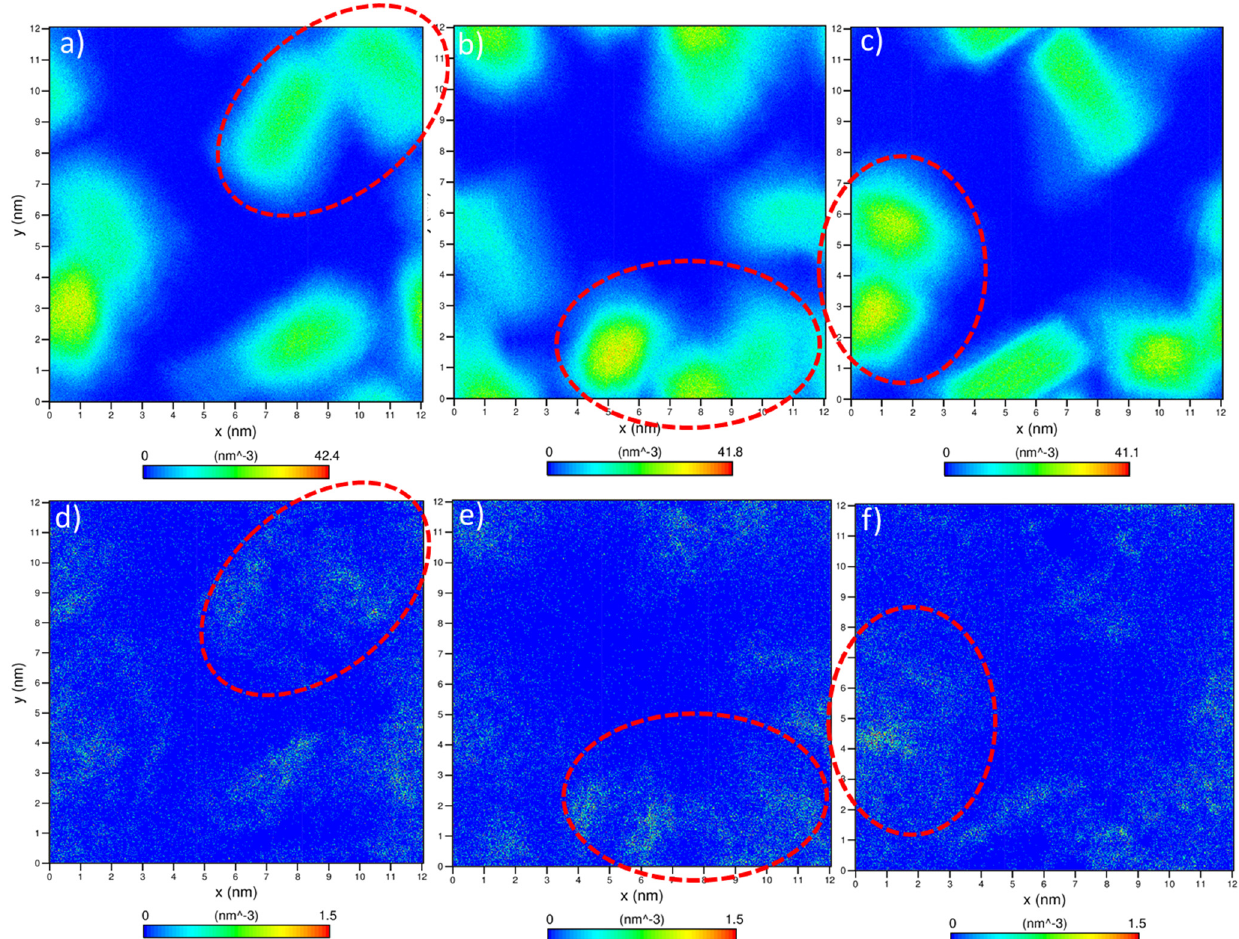
Figure 7. Density maps of the self ‐ assembled laponite disks in the presence of ( a ) CaCl 2 , ( b ) MgCl 2 and ( c ) CsCl and the accumulated ( d ) Ca 2+ , ( e ) Mg 2+ and ( f ) Cs + on the surface of self ‐ assembled disks. In ( d , e , f ) representations, the laponite disks and the water molecules are not visible. The data are averaged over the last 5 ns of the simulation time. Periodic boundary conditions are applied to all density maps in x, y and z directions.